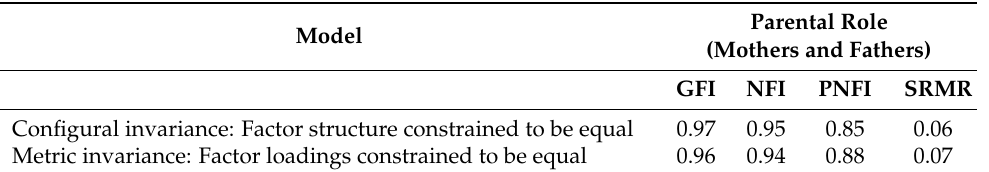
Table 4. Results of the Measurement Invariance test across parental role groups.